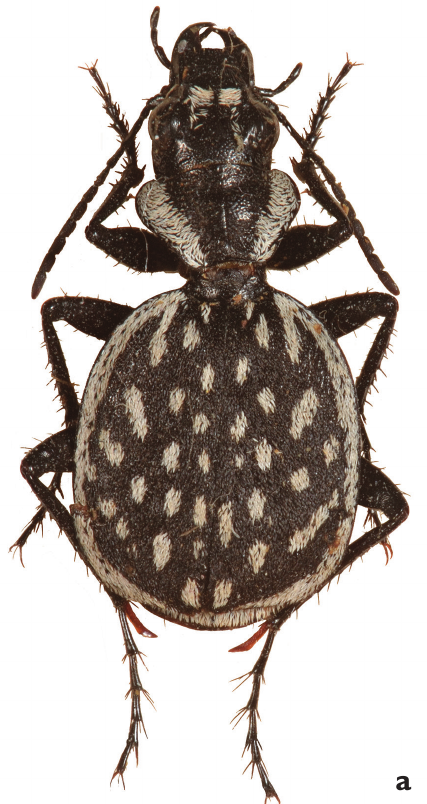
a Figure 23. Dorsal habitus of Graphipterus : a G. minutus minutus b G. minutus goryi.